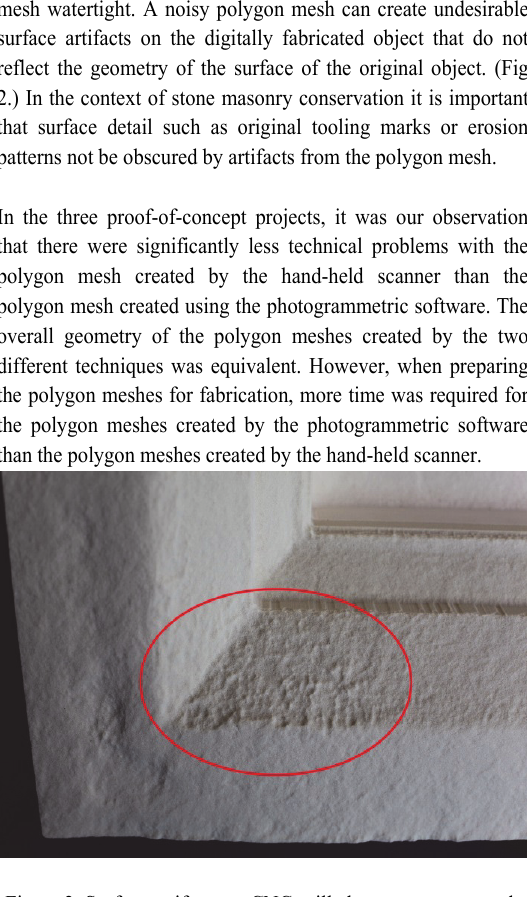
Figure 2. Surface artifacts on CNC-milled maquette as a result of poor mesh quality